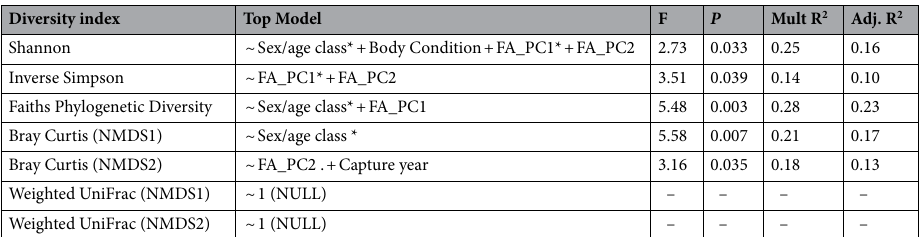
Table 2. Summary of top models showing influence of diet (FA_PC1 and FA_PC2 axes) and other relevant metadata on variation in alpha diversity indices (Shannon, Inverse Simpson, Faith’s phylogenetic distance) and beta diversity indices (Bray–Curtis and weighted UniFrac distances) for the subset of Southern Beaufort Sea (SB) polar bears for which diet data was available. There were no significant terms in models explaining variation using weighted UniFrac beta diversity axes.